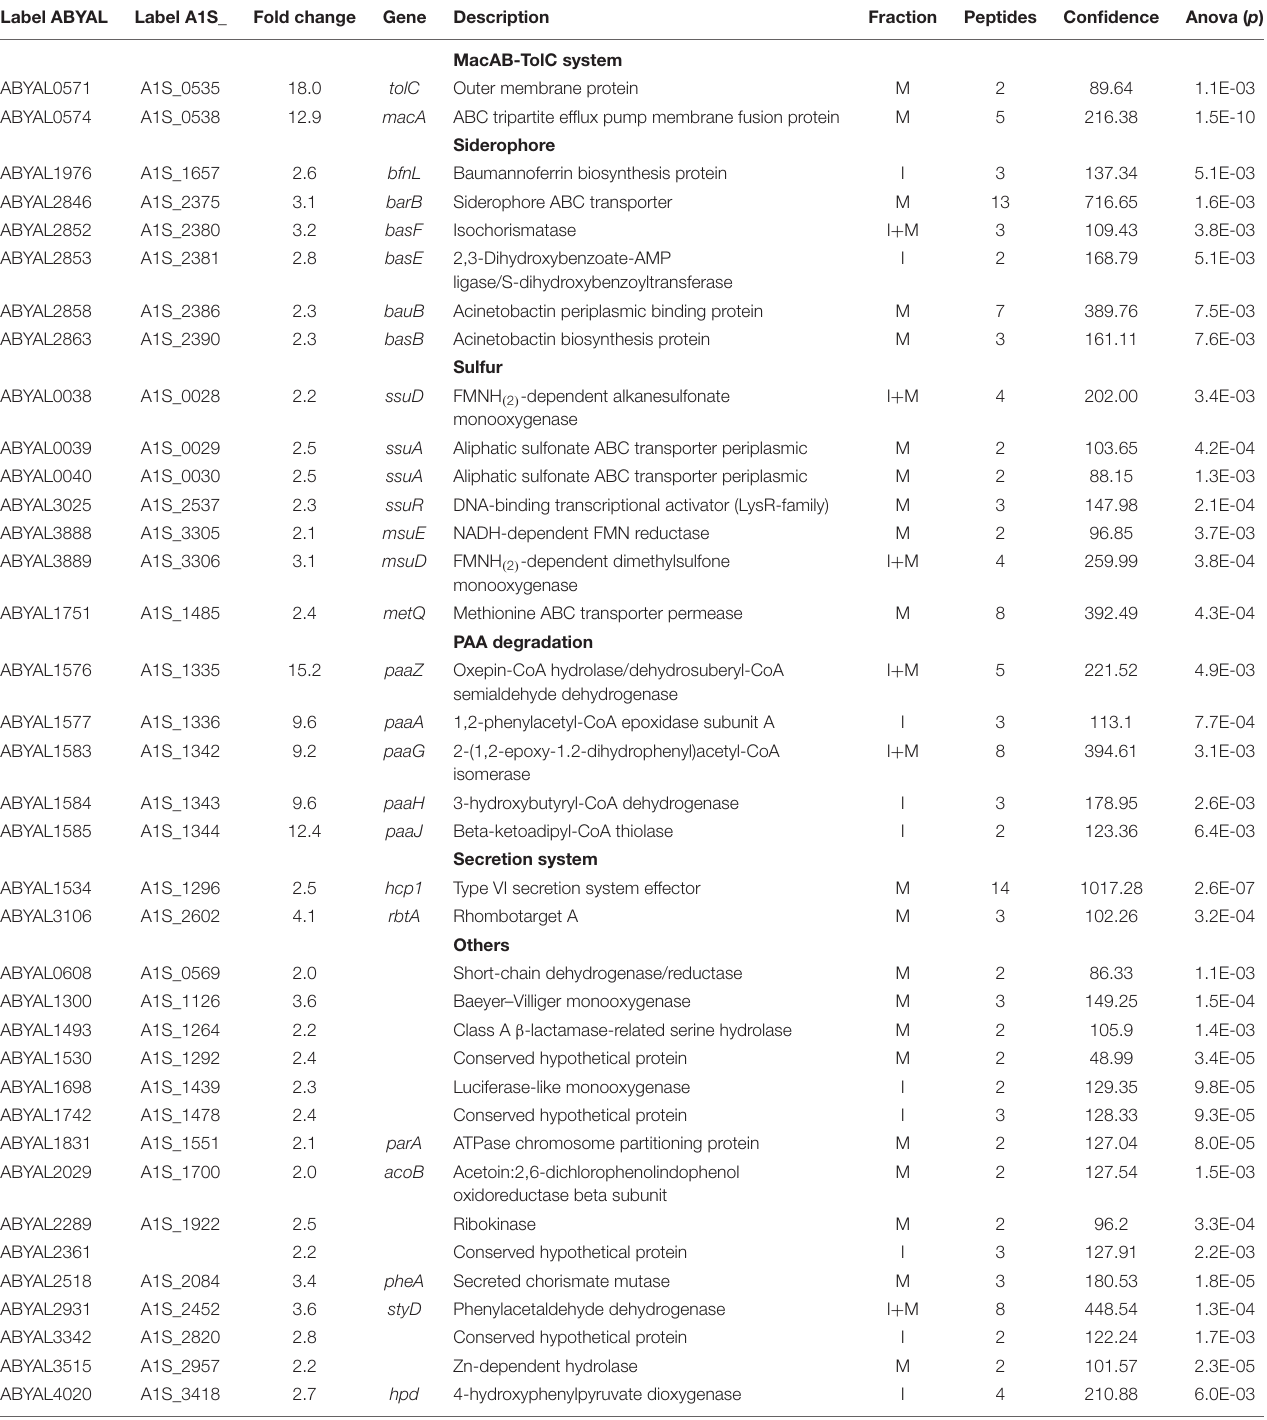
TABLE 1 | Proteins under-represented in solid–liquid biofilm of (cid:49) Mac. Label ABYAL Label